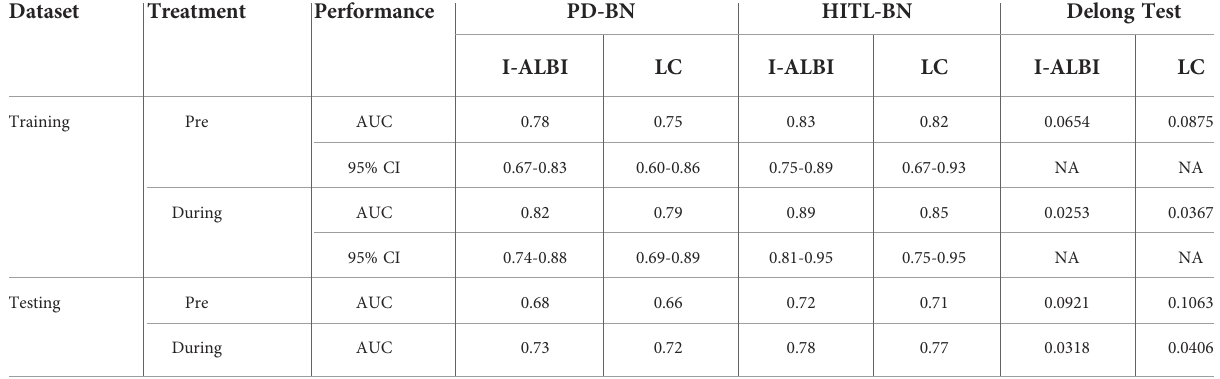
TABLE 7 The results of numerical